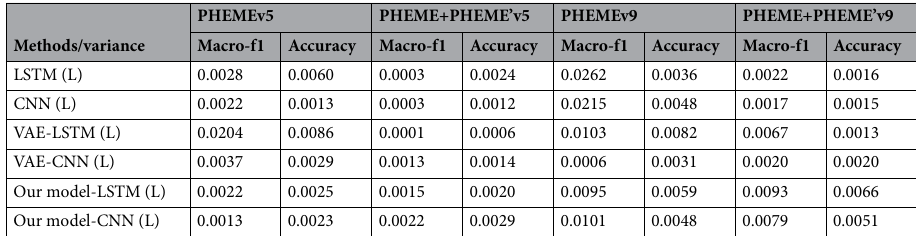
Table 2. Variance results in cross-validations on the rumor detection